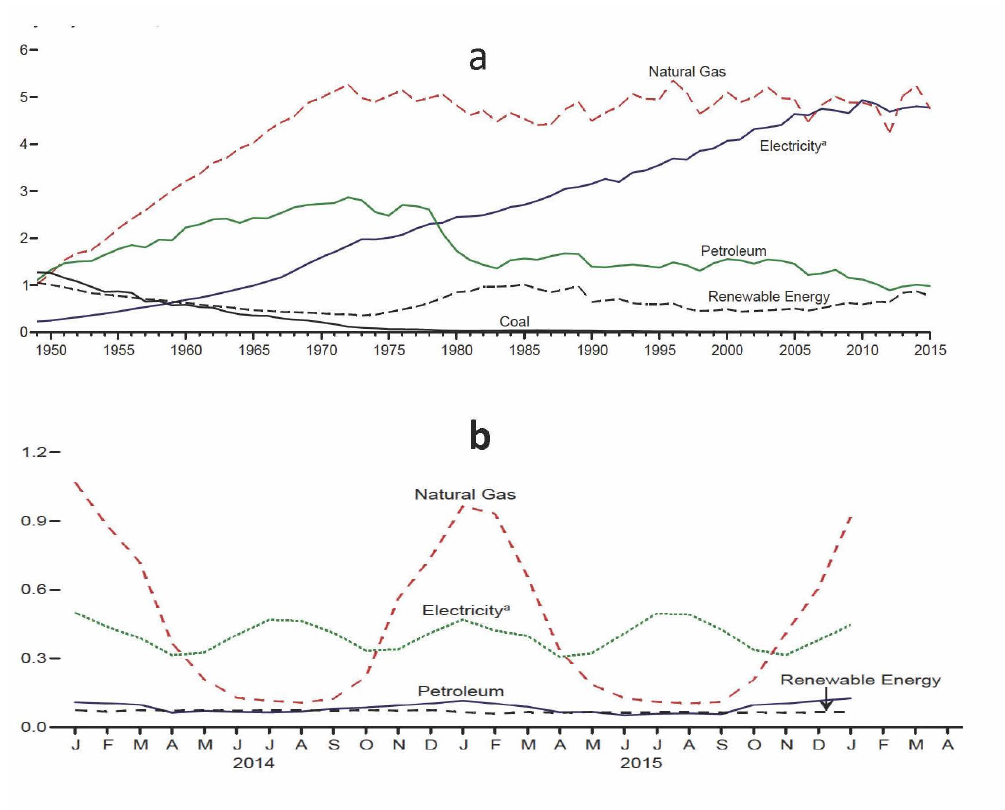
Figure 1. Energy major sources in U.S. ( a ) yearly data from 1949; ( b ) monthly data of 2014 and 2015, Source: U.S. Energy Information Administration